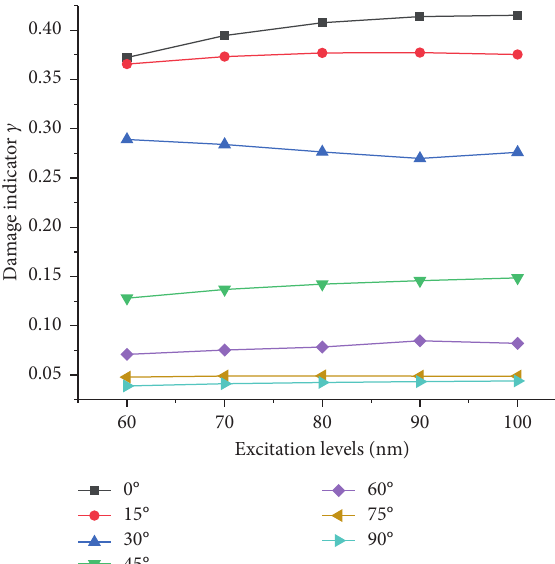
Figure 7: Amplitude of fundamental A A 2 for various crack angles.